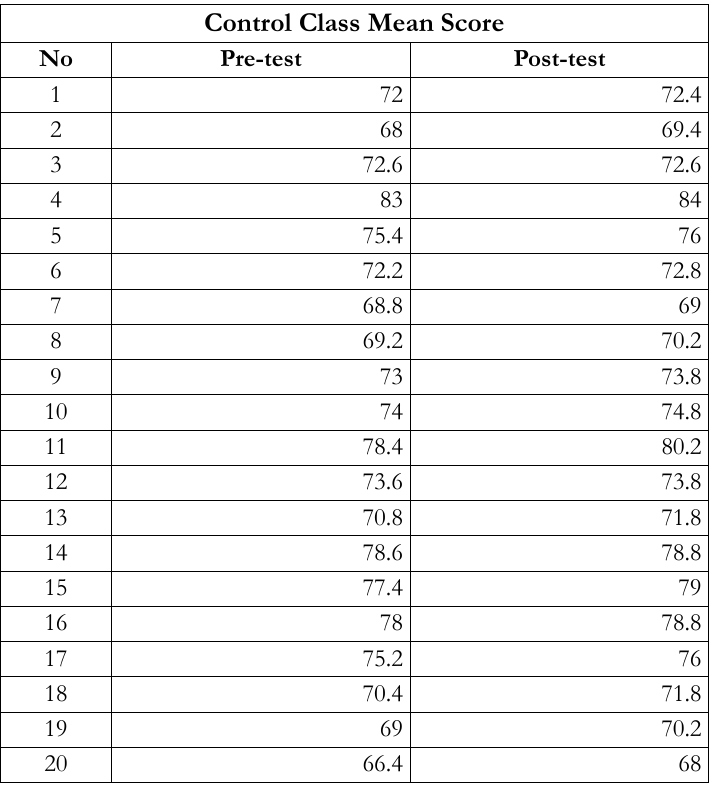
Table 2. The Score of the Control Class on Pre-test and Post-test